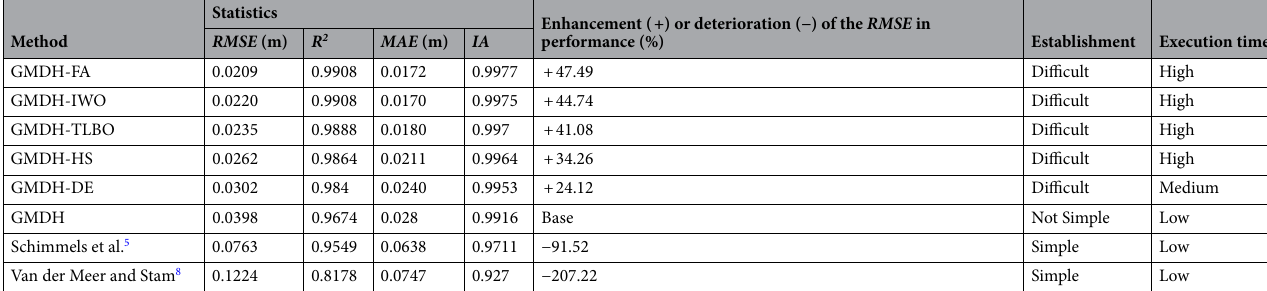
Table 5. S tatistical parameters for the evaluation of the performance of derived models at a testing stage.